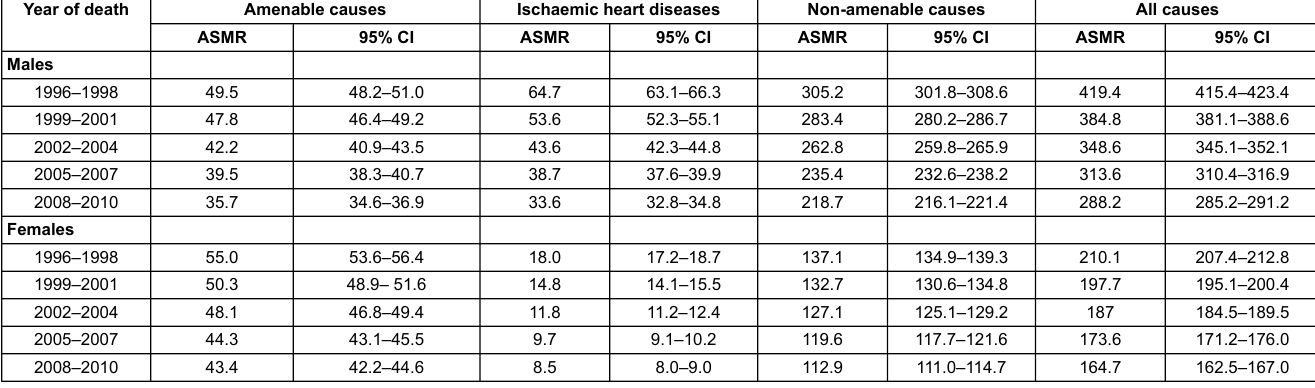
Table 2: Three-year age-standardised mortality rates (ASMR) (European standard [32]) per 100 000 person-years, 95% confidence intervals (95% CI), age 0–74 years: amenable causes, ischaemic heart diseases, non-amenable causes and all causes by sex for the population of Switzerland, time period